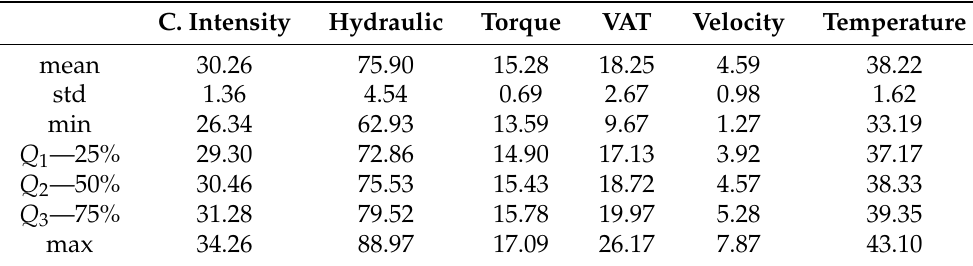
Table 1. Statistical parameters of the dataset variables, before processing: C. intensity, hydraulic unit oil level, torque, VAT pressure, velocity, and temperature.